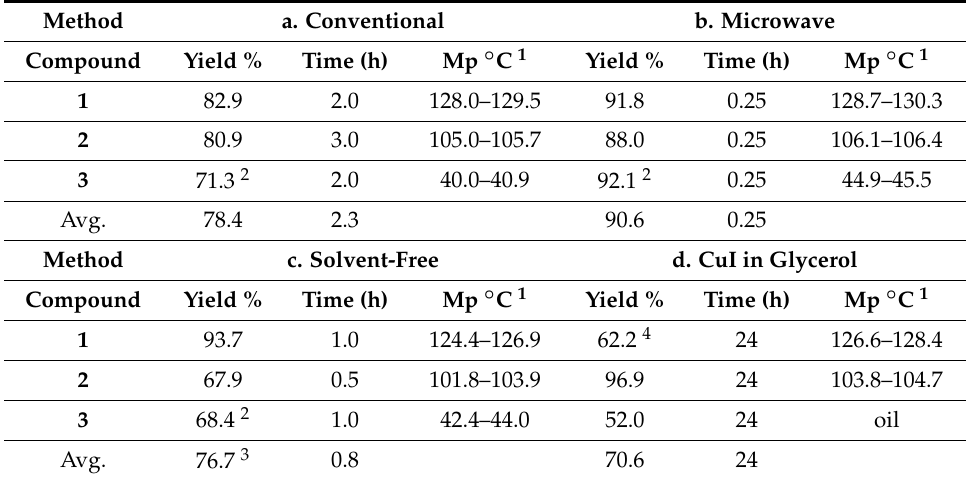
Table 2. Synthesis of triazoles by four sets of conditions (highest two trials per entry).